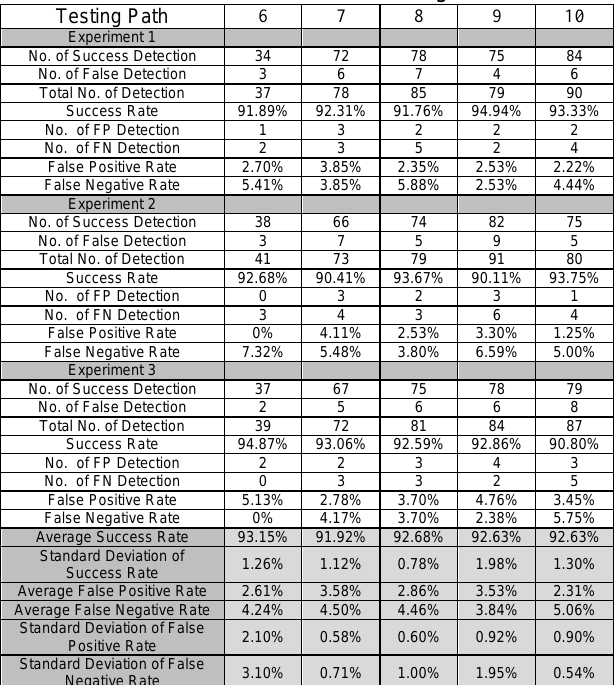
Table 3. Conclusive Results for Testing Path 6 to